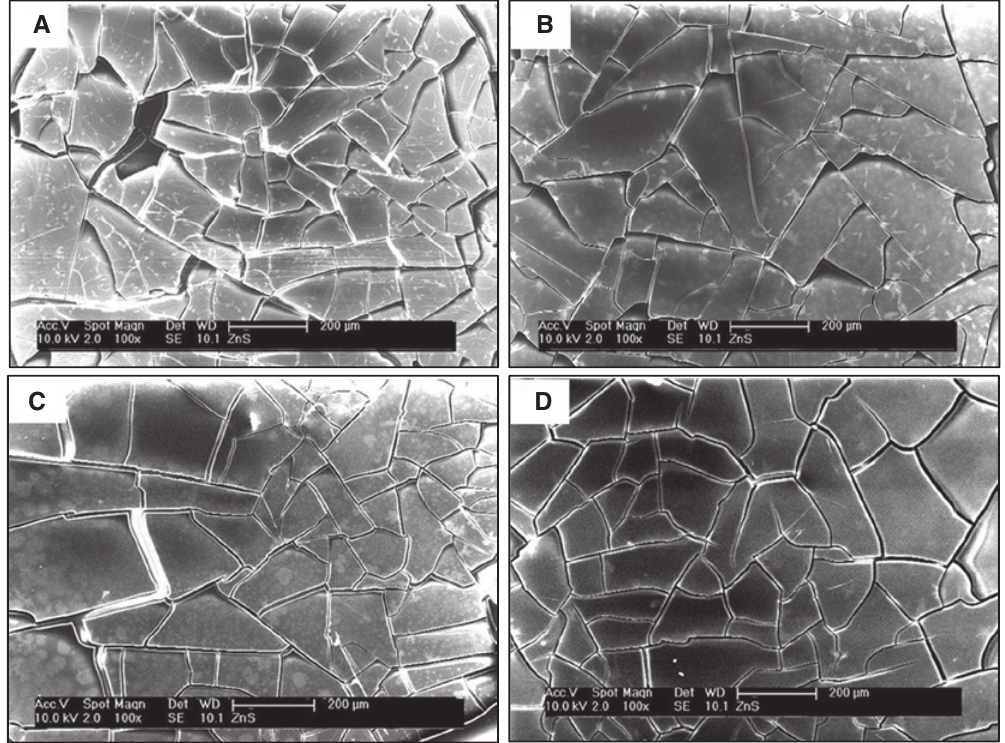
Figure 9: SEM micrographs of PDD incorporated with the uncapped ZnS nanoparticles (A) 1% PEG (B), 3% PEG (C), and 5% PEG (D) ZnS